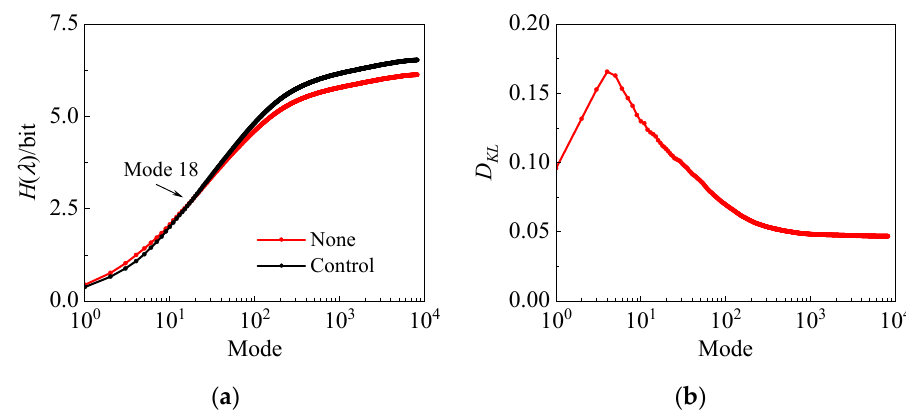
Figure 4. The profiles of ( a ) information entropy and ( b ) relative entropy.